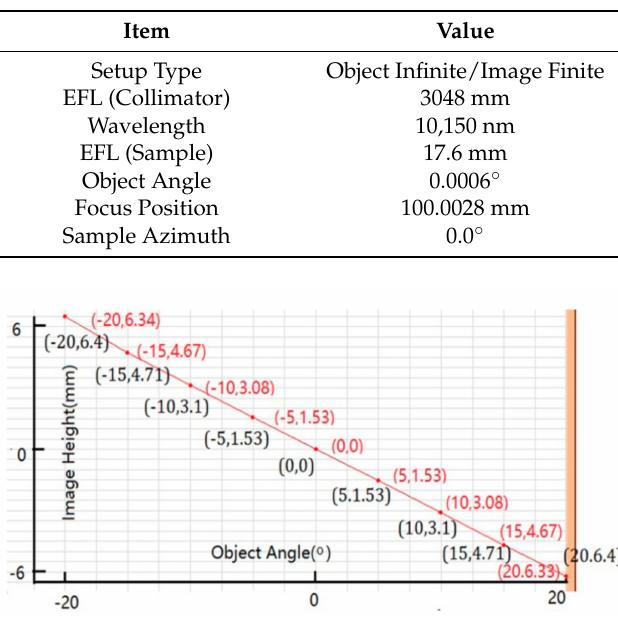
Table 5. Measurement parameters: Image height vs. object angle.